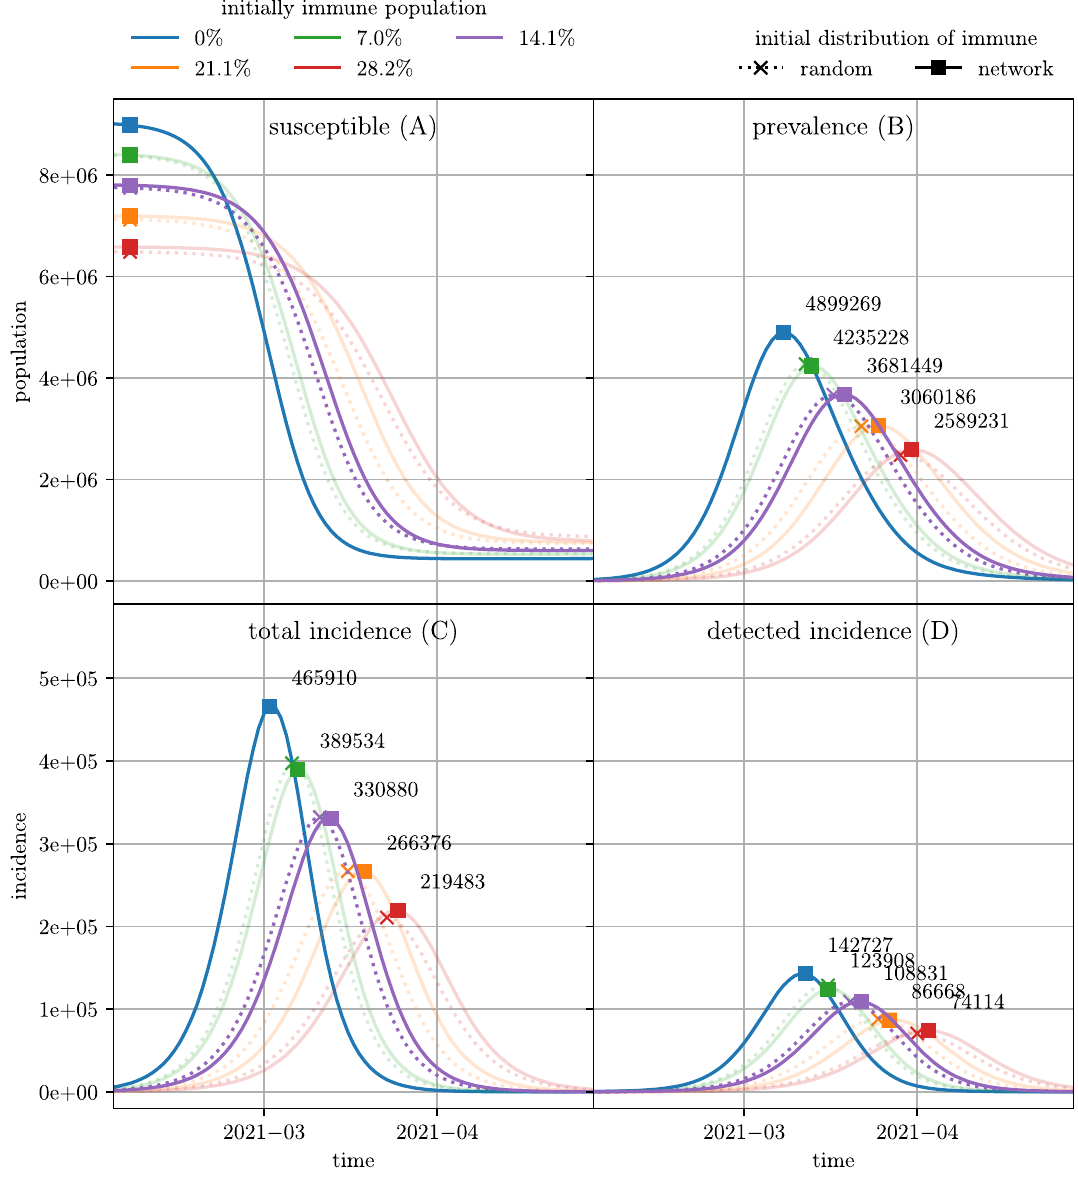
Figure 4. Various outcome measures for scenarios with different initially immunization levels. Simulation results for all scenarios with varying immunization level and distribution of initially immune individuals are depicted. Panel A depicts the number of susceptible individuals and Panel B depicts the number of currently infected individuals. Panel C depicts the daily incidences for all cases of SARS-COV-2 infections and Panel D depicts the daily incidences for the confirmed SARS-COV-2 infections. For each timeline, the maximum of the curve is